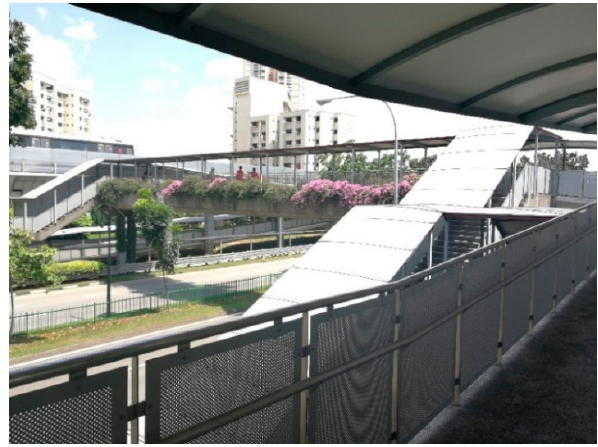
Figure 6. An overhead bridge with stairs and long